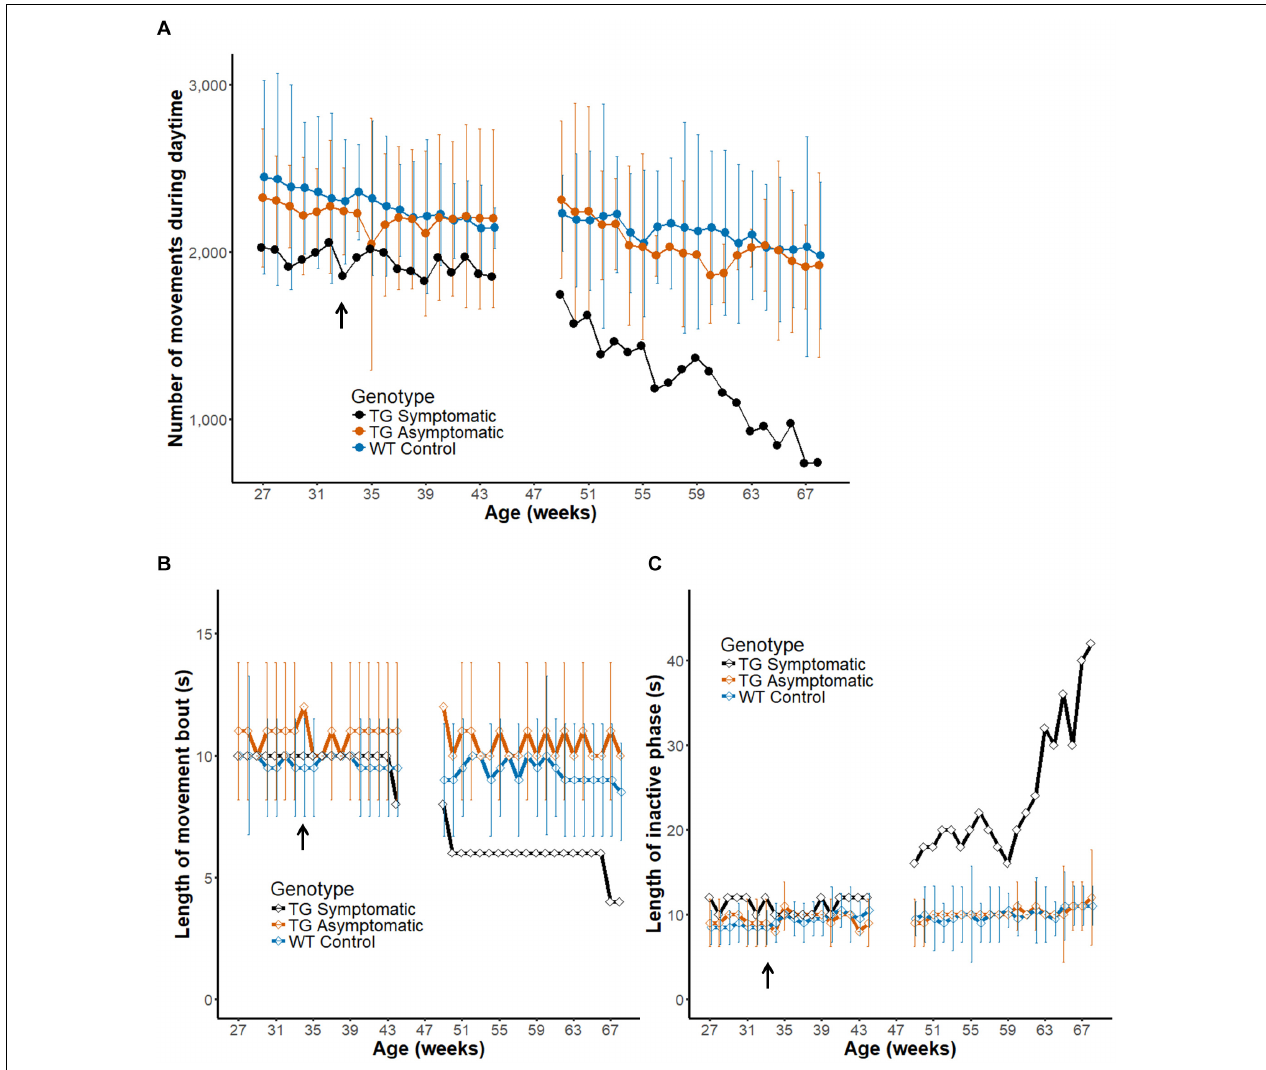
FIGURE 7 | Intermittent nature of activity represents the progression of disease in a transgenic marmoset. (A) Number of movements during daytime before and after the onset of diagnosed symptoms (33 weeks of age, arrow in the horizontal axis) in a transgenic marmoset ( n = 1, black) and age-matched asymptomatic ( n = 2, orange) and wild-type ( n = 4, blue) animals (group mean ± 2 SD). Note that the measurement was paused from weeks 45 to 48 as the transgenic animal was temporality transferred to another cage for a neuroimaging experiment. (B,C) Longitudinal changes in the length of movement bout (B) and inactive phase (C) . Group mean ( ± 2 SD) of the index is plotted as a function of mean age. The movement bout decreased and the inactive phase increased as a function of age after disease onset in the symptomatic transgenic animal. Note that the score obtained for a symptomatic marmoset after disease onset was generally beyond the 2 SD range of that obtained for wildtype controls or asymptomatic